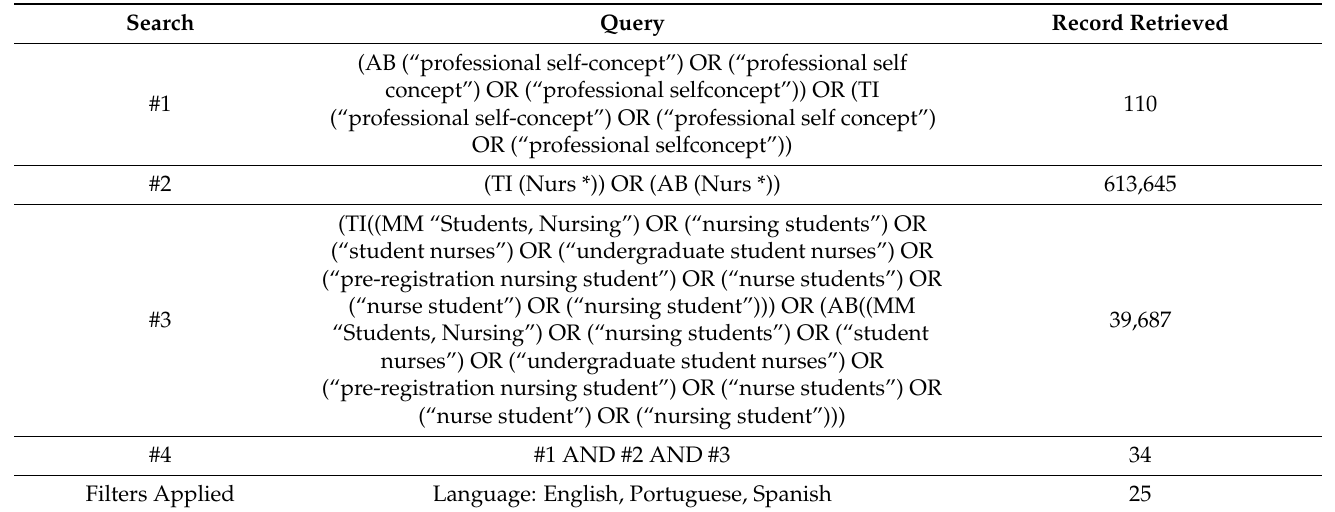
Table 1. Search strategy for EBSCOhost (CINAHL complete). The search was conducted on 13 September